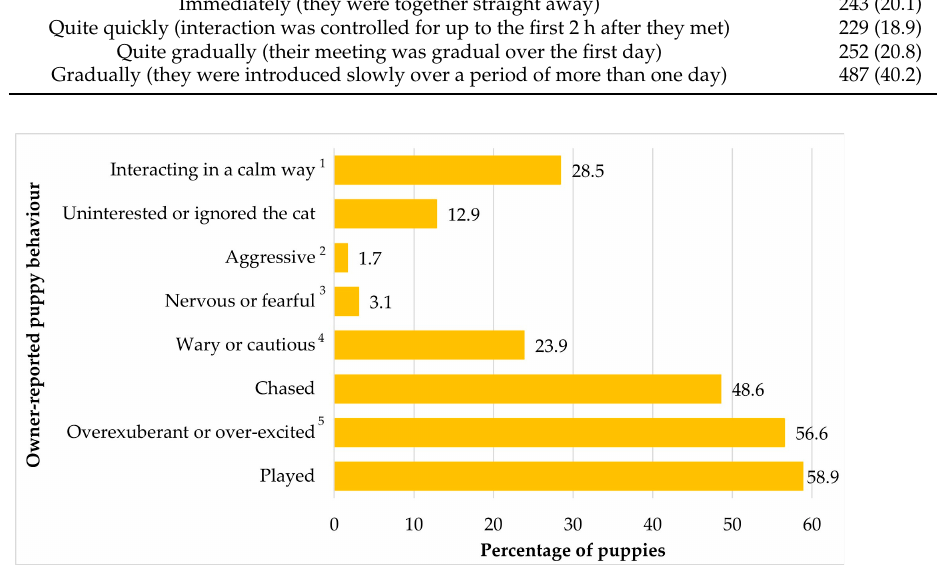
Figure 1. Owner-reported behaviour displayed by 1211 puppies towards existing household